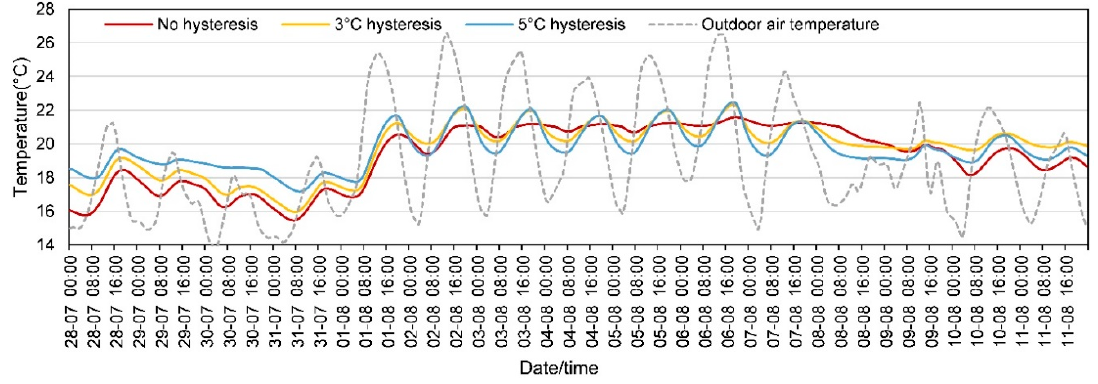
Figure 8. The PCM temperature profiles for models using PCM with different hysteresis degrees for summer night cooling application.